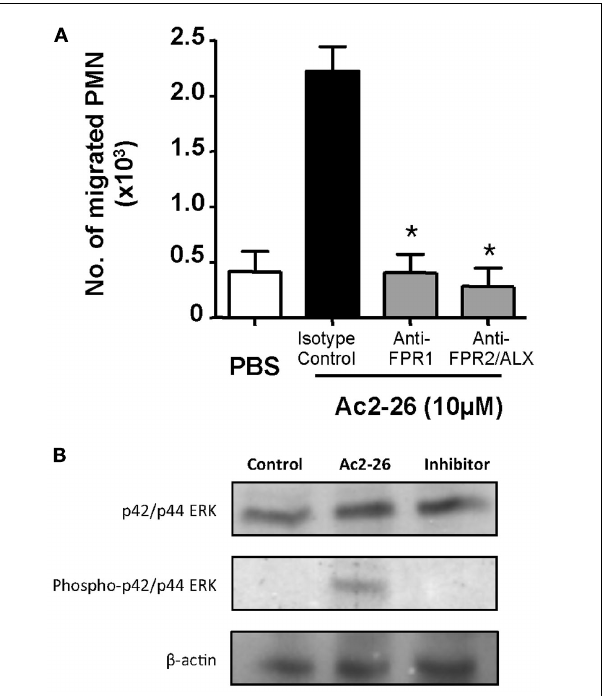
FIGURE 3 | Both FPR1 and FPR2/ALX mediate peptideAc2-26 induced PMN migration. (A) Peripheral blood neutrophils were pre-incubated for 5min at RT with anti-FPR1, FPR2/ALX, or an Isotype control antibody, prior to loading on to a 96 well ChemoTx™ plate in the presence of 10 μ M peptide Ac2-26. Chemotaxis was evaluated after a 90-min incubation at 37˚C and 5% CO 2 . Results are ± SEM from three distinct cell preparations (* P < 0.05 vs. isotype control). (B) Ac2-26 (10 μ M) was added to peripheral blood neutrophils in the presence of absence of PD98059 (ERK inhibitor; 10 μ M) for 5min prior to protein extraction and assessment of phospho- and total ERK isoforms, as well as beta-actin. Blots are representative of triplicate analyses conducted with two distinct neutrophil